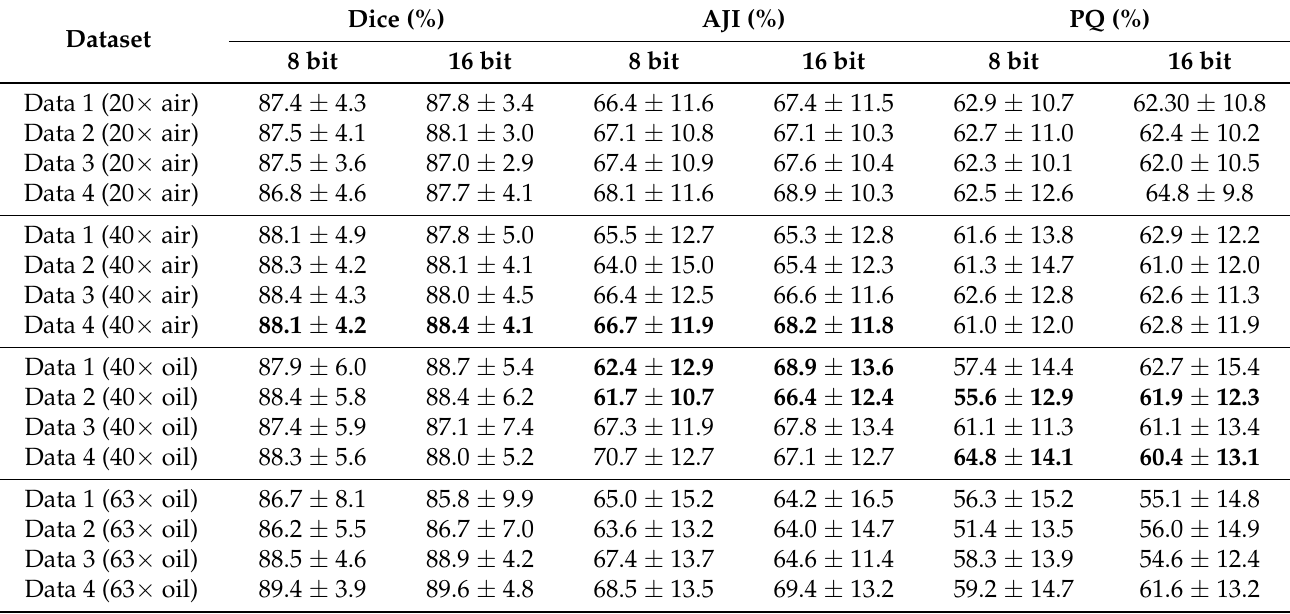
Table 2. Fluorescence-stained nuclei instance segmentation performance of the BitDepth dataset based on image bit depth at different image magnifications. In cases, where the segmentation performance of 8 bit images differed significantly ( p -values < 0.05) from that of 16 bit images, the results are shown in